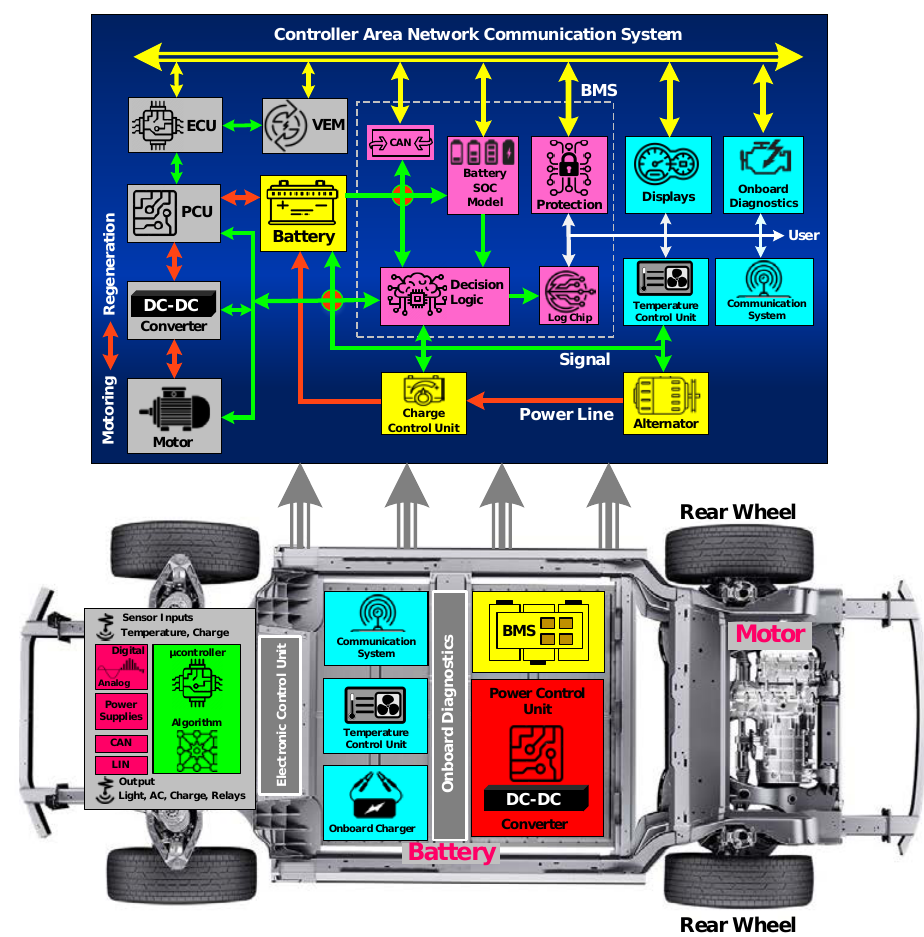
Figure 3. Energy management and charging communication.